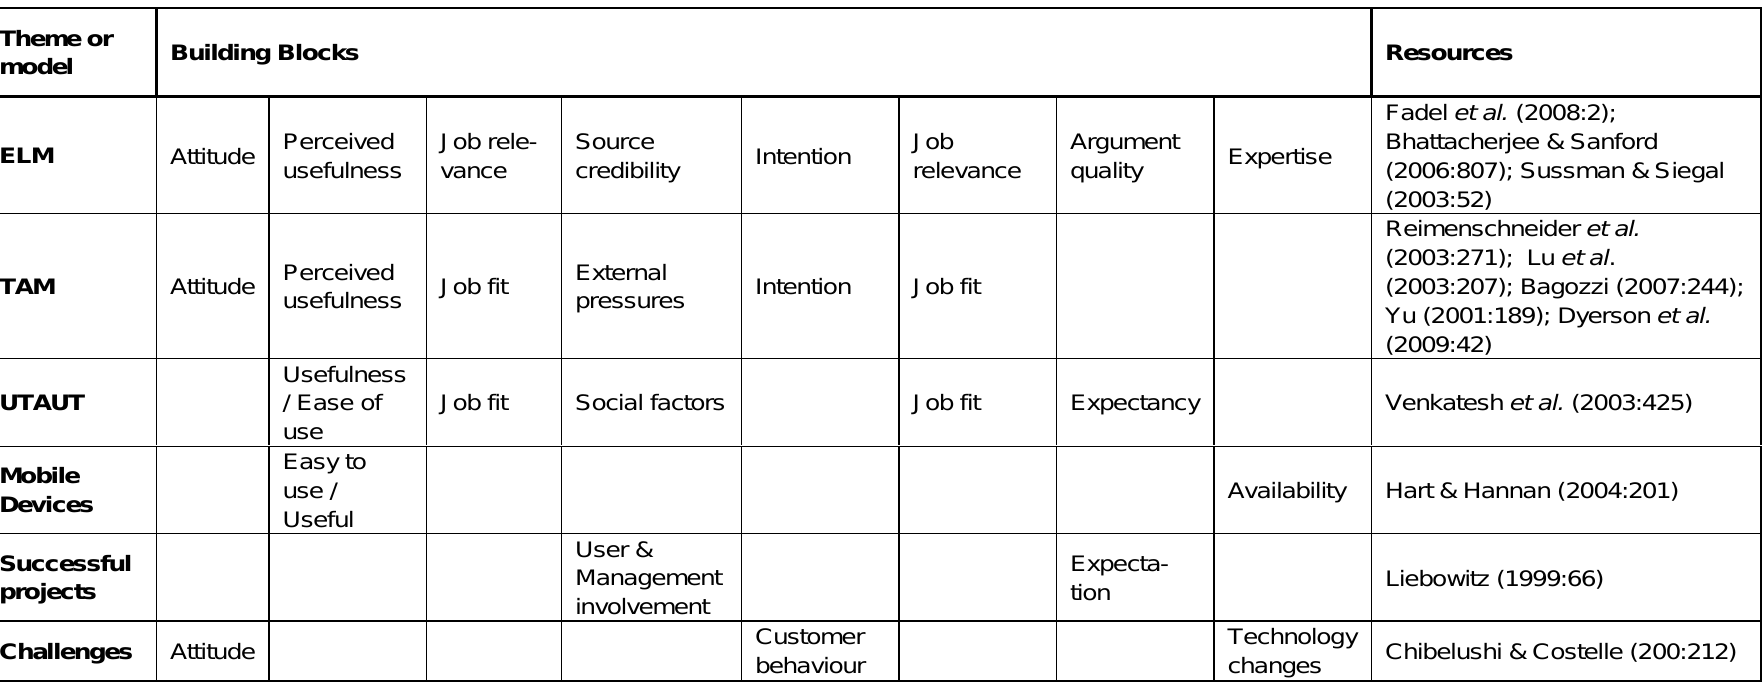
Table 2. Building